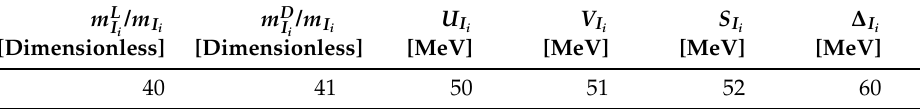
Table 3. Indices for microscopic